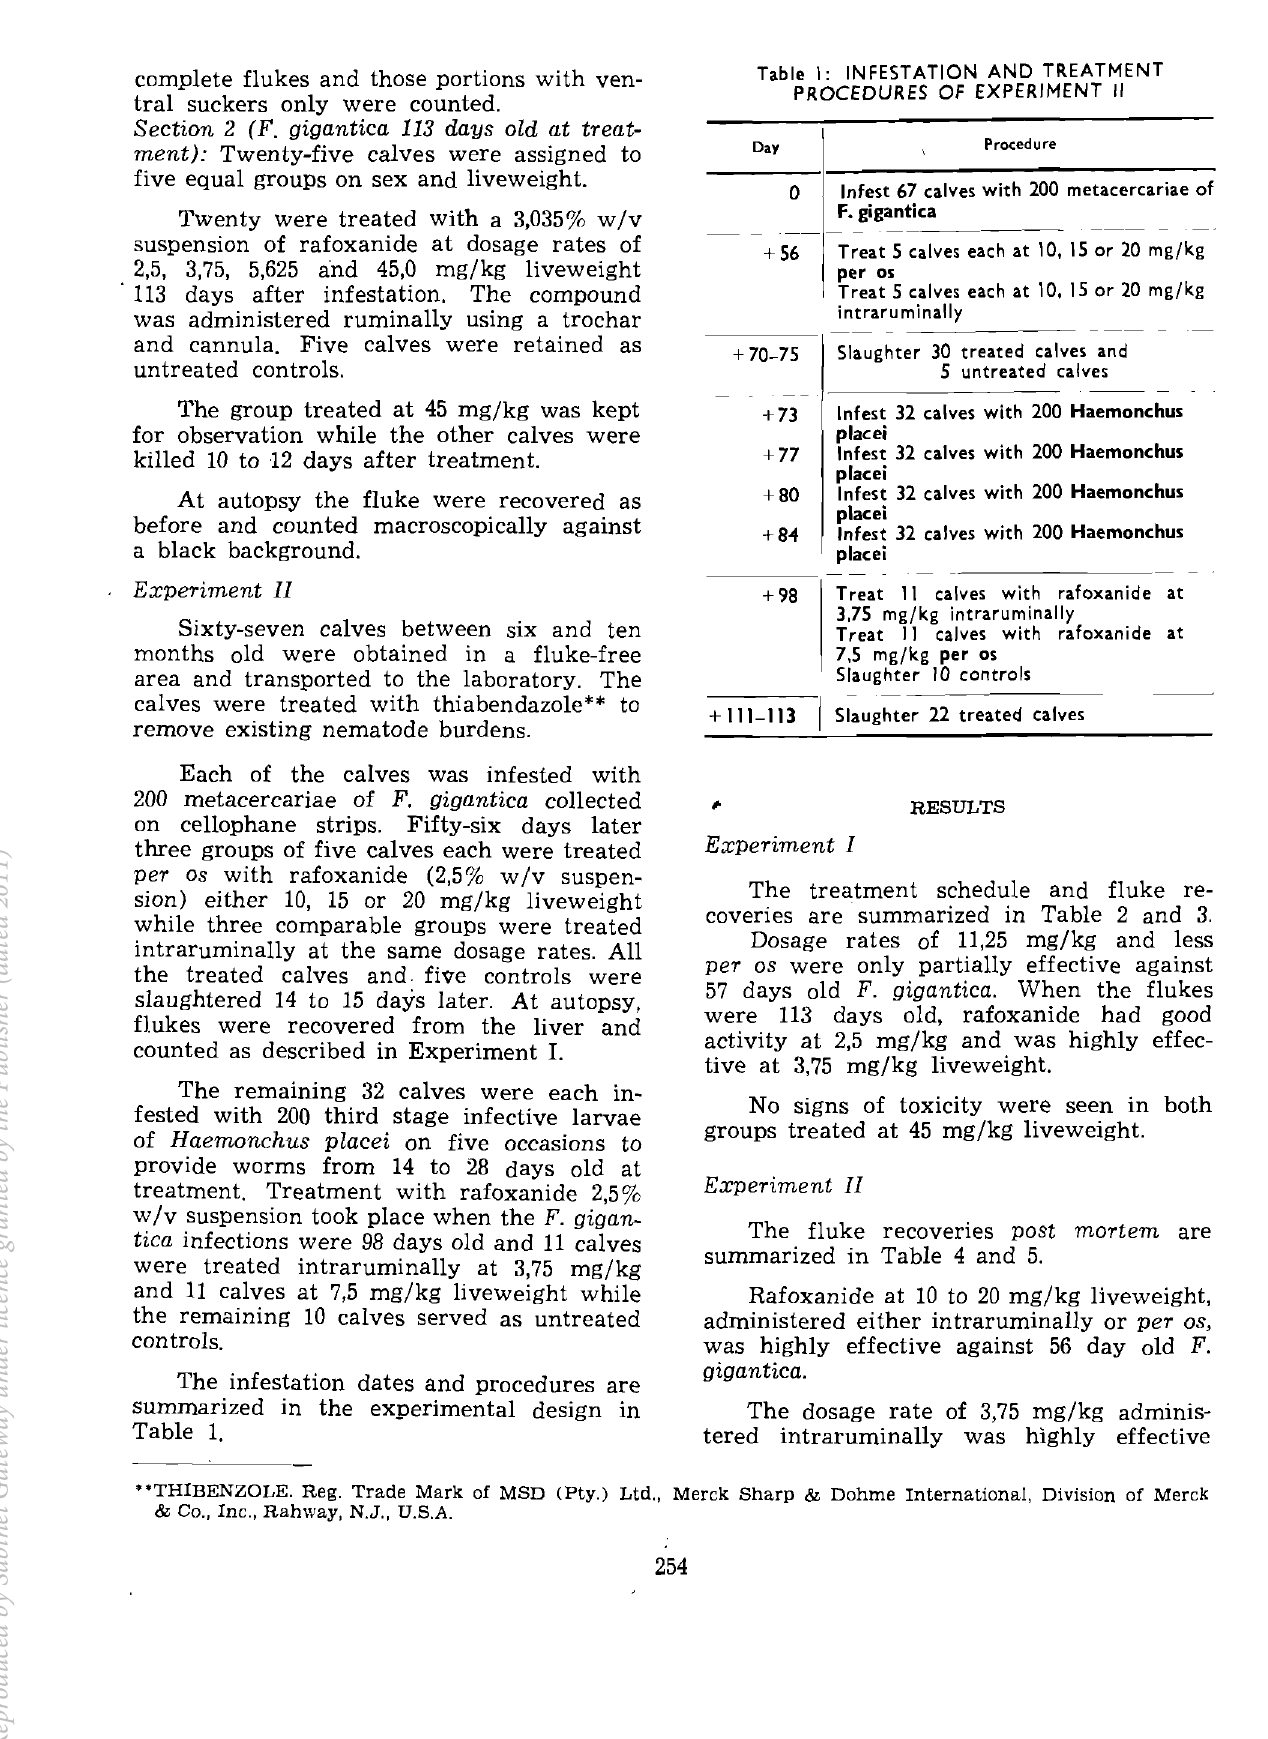
Table I: INFESTATION AND TREATMENT PROCEDURES OF EXPERIMENT" Day ,